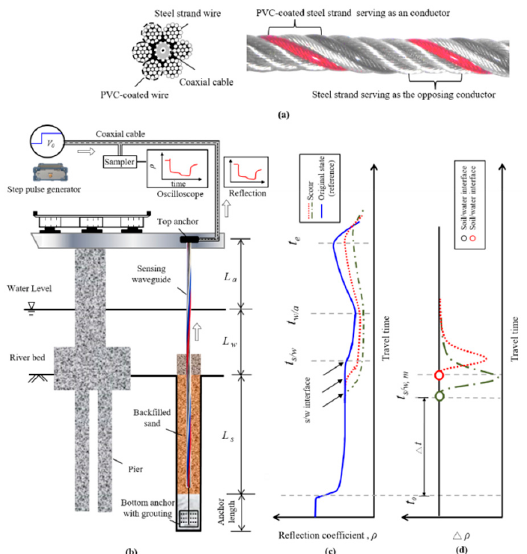
Figure 1. ( a ) Schematic and photo of the TDR sensing cable; ( b ) illustration of TDR bridge scour monitoring; ( c ) illustration of TDR bottom-up measurement waveforms and definition of various reflection arrival times; and ( d ) illustration of time-lapse differential waveform method to clearly identify reflection from the sediment/water interface.